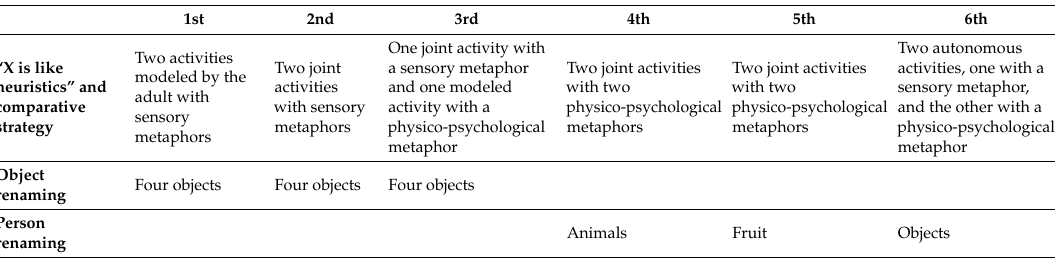
Table 4. Schedule of the activities in each session.